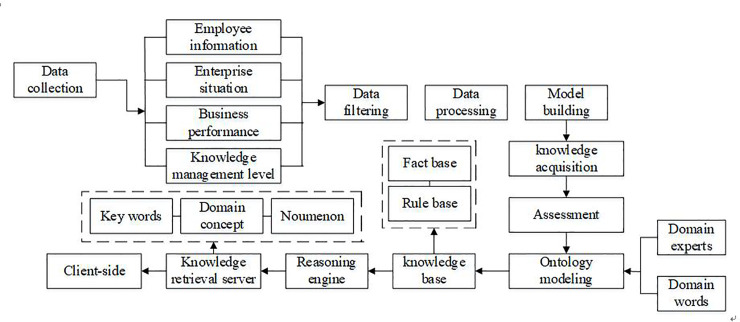
The idea of constructing an enterprise management model.